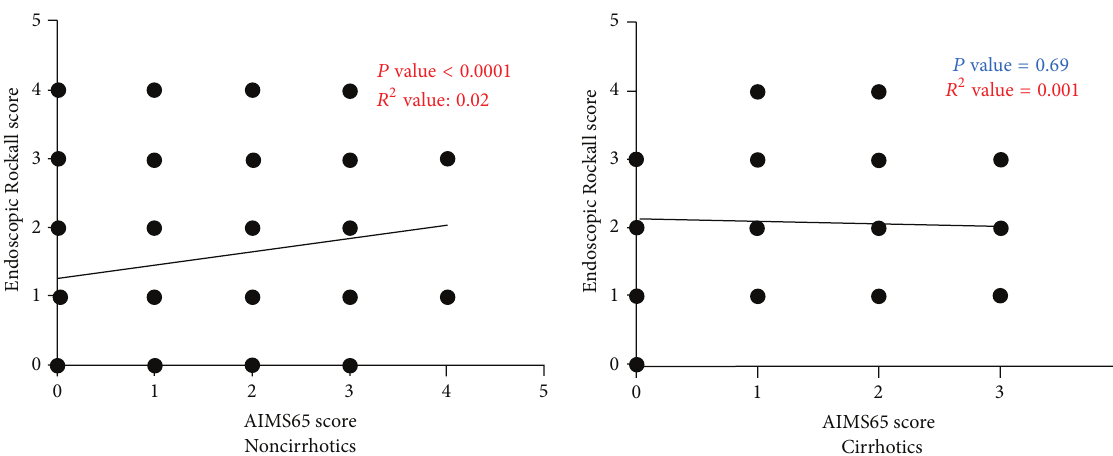
Figure 4: Statistically significant correlation was found between Endoscopic Rockall scores and AIMS65 scores in noncirrhotic patients but not cirrhotic patients ( P value = 0.69).